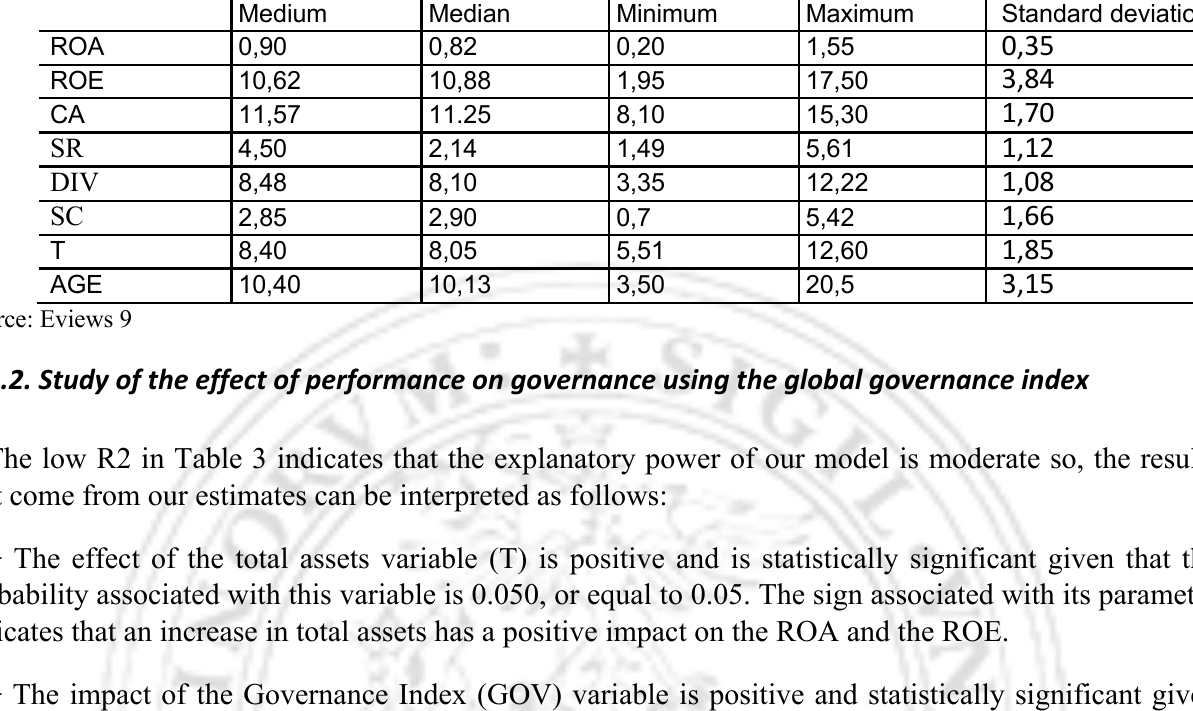
Table 2: Descriptive Statistics.